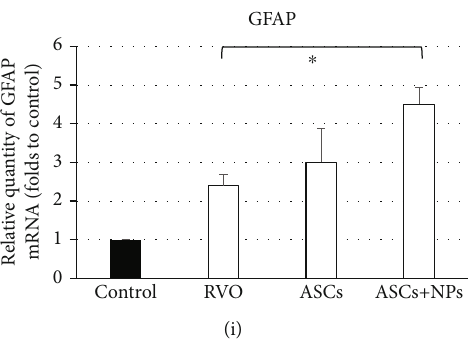
Figure 5: Expression of RVO, in fl ammation, and regeneration-related genes in all groups as was evaluated by real-time PCR analysis 2 weeks following transplantation. Data are expressed as the mean ± SD ( ∗∗ P < 0 : 01 , ∗ P < 0 : 05 vs. control; n = 3